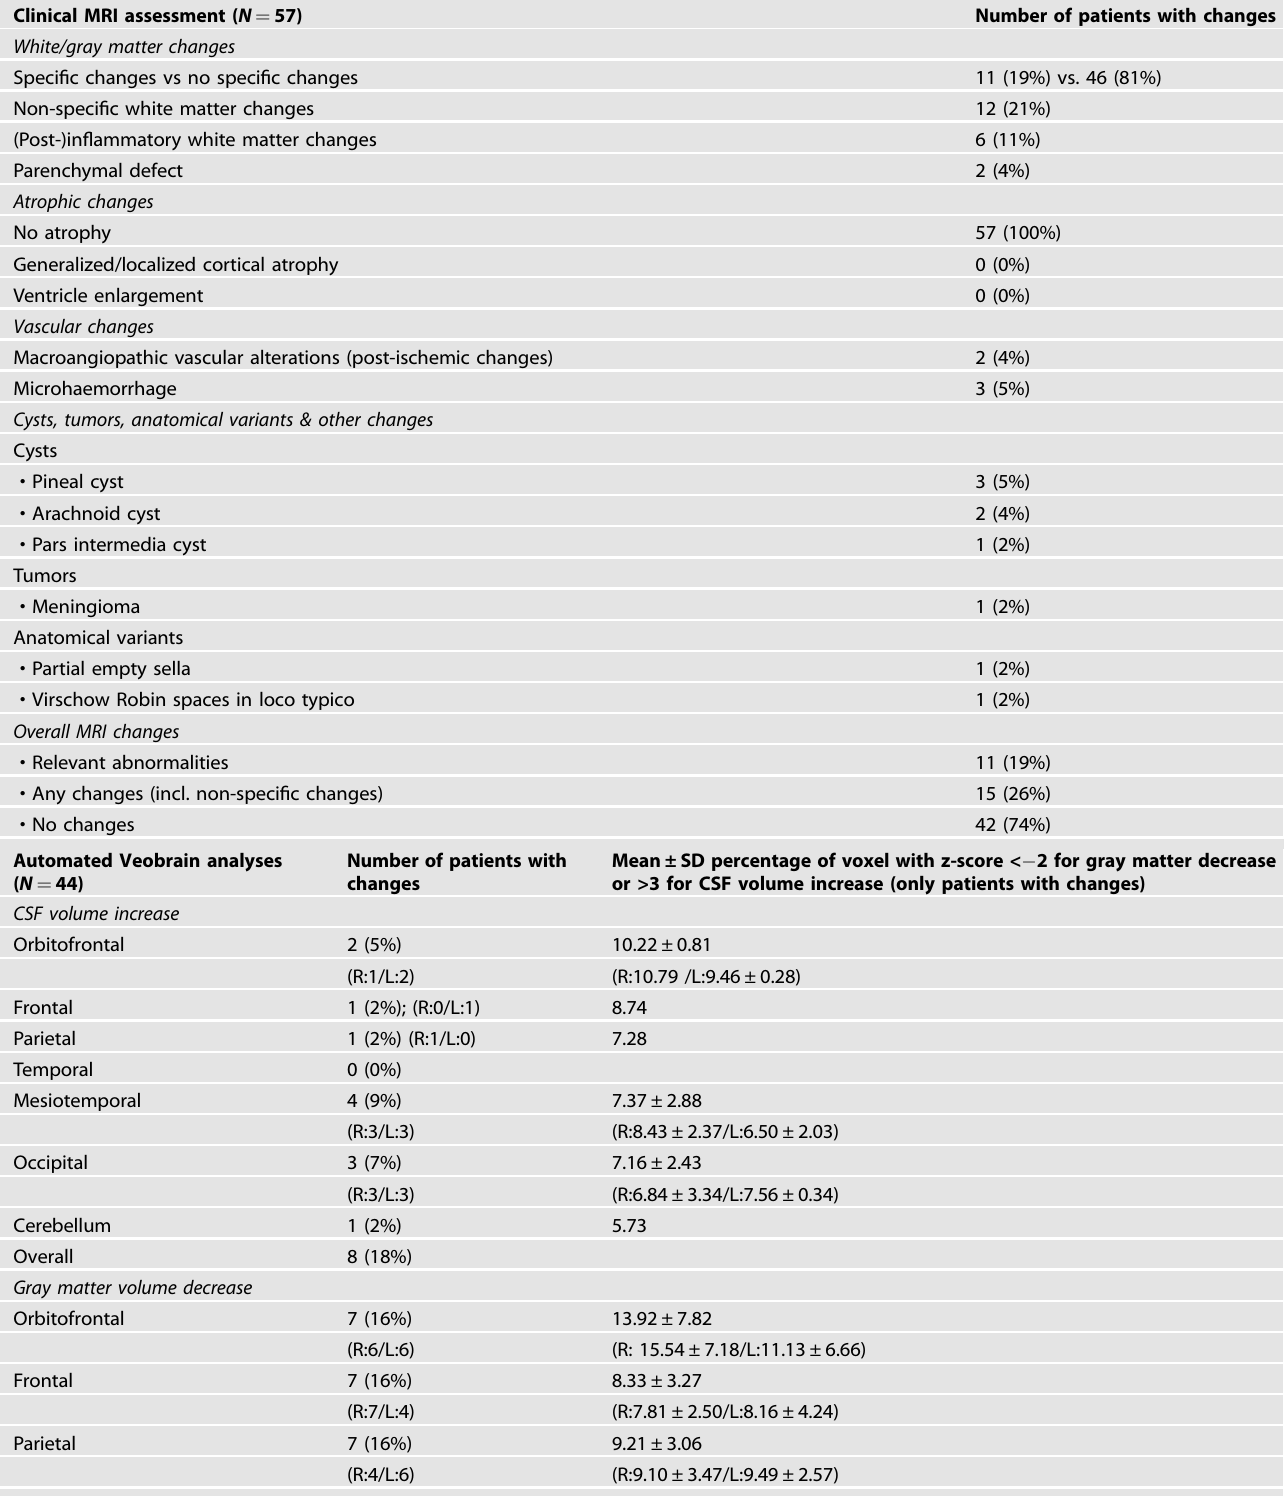
Table 4. Magnetic resonance imaging (MRI) fi ndings in clinical assessment and using automated Veobrain analysis (available in most patients), as well as electroencephalography (EEG)